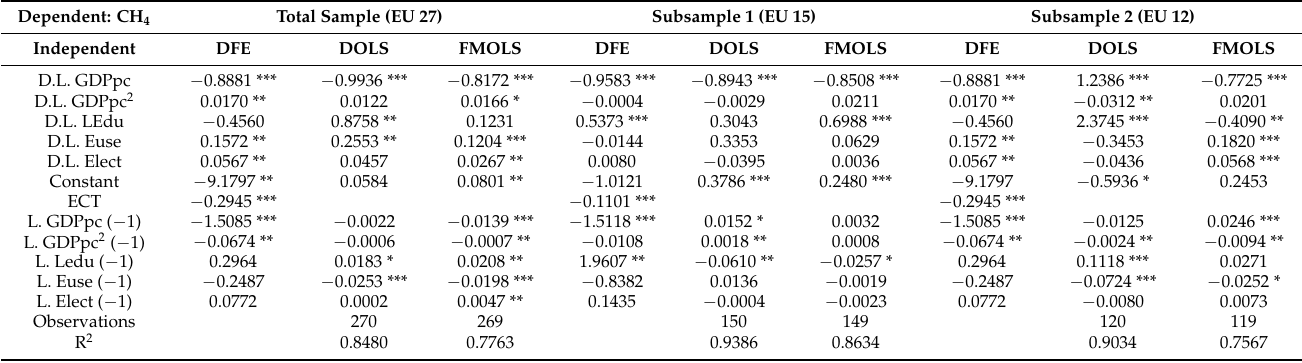
Table 7. DFE, DOLS, and FMOLS results for the total sample (EU-27), subsample 1 (EU-15), subsample 2 (EU-12) regarding Equation